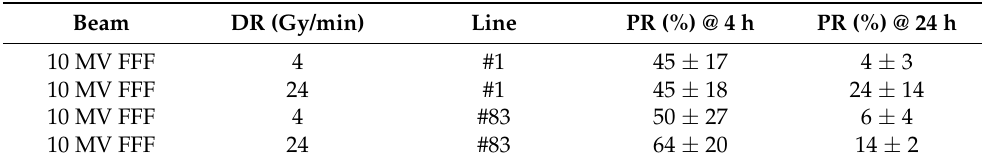
Table 3. PR of total fluorescence intensity after exposure to 20 Gy with FFF beam at different dose rates for GSC line #1 and line #83.